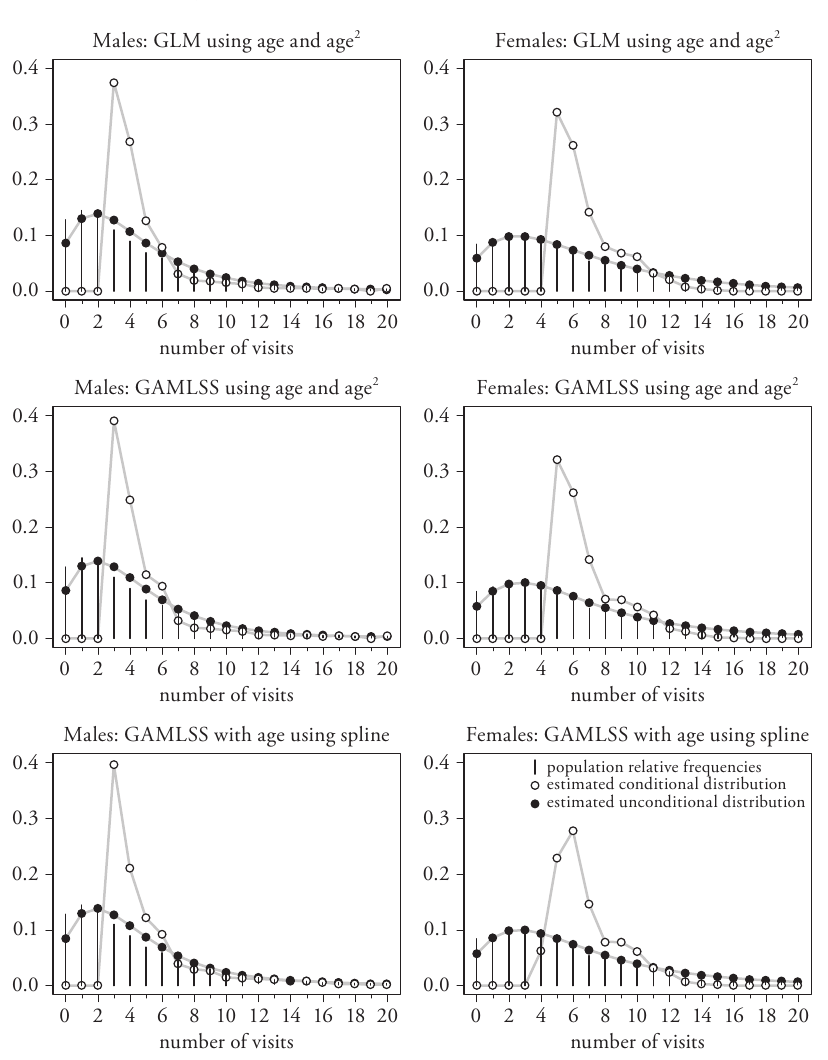
Figure 8: Predicted population distribution for